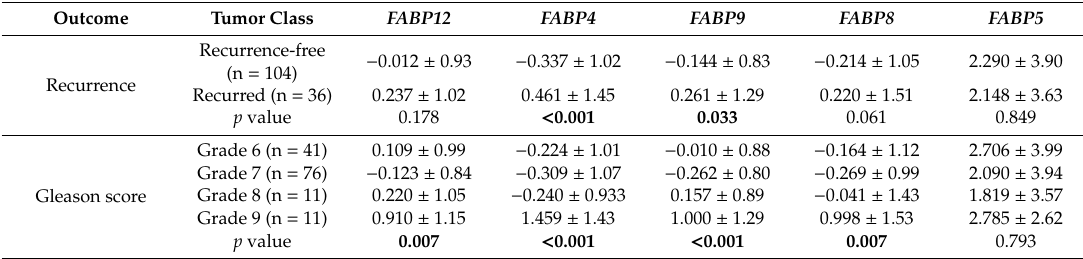
Table 1. Correlations of FABP levels with clinical outcomes.